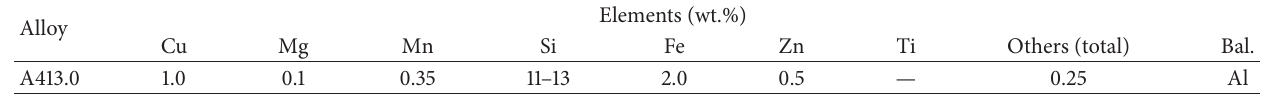
Table 1: Chemical composition of as-received A413.0 alloy.